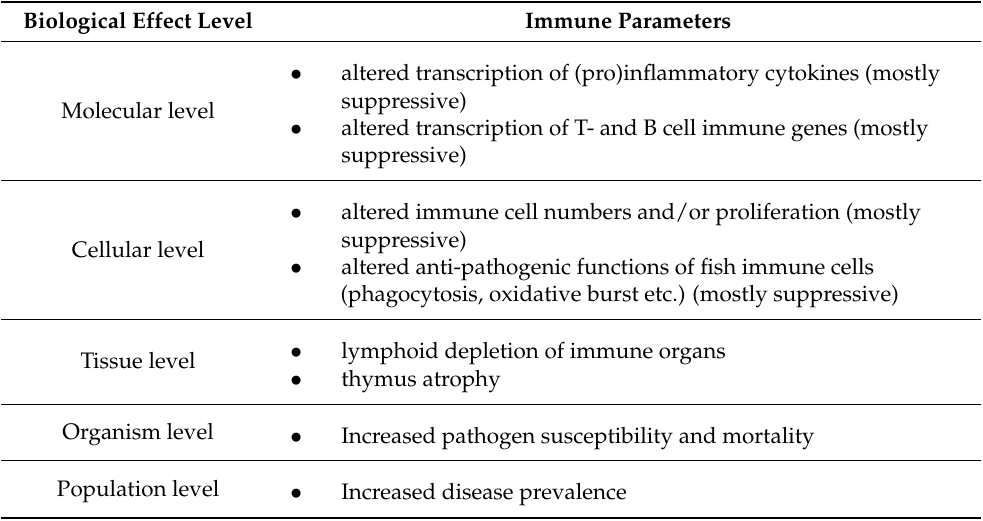
Table 2. Summary of impacts of xenobiotic AhR agonists on fish